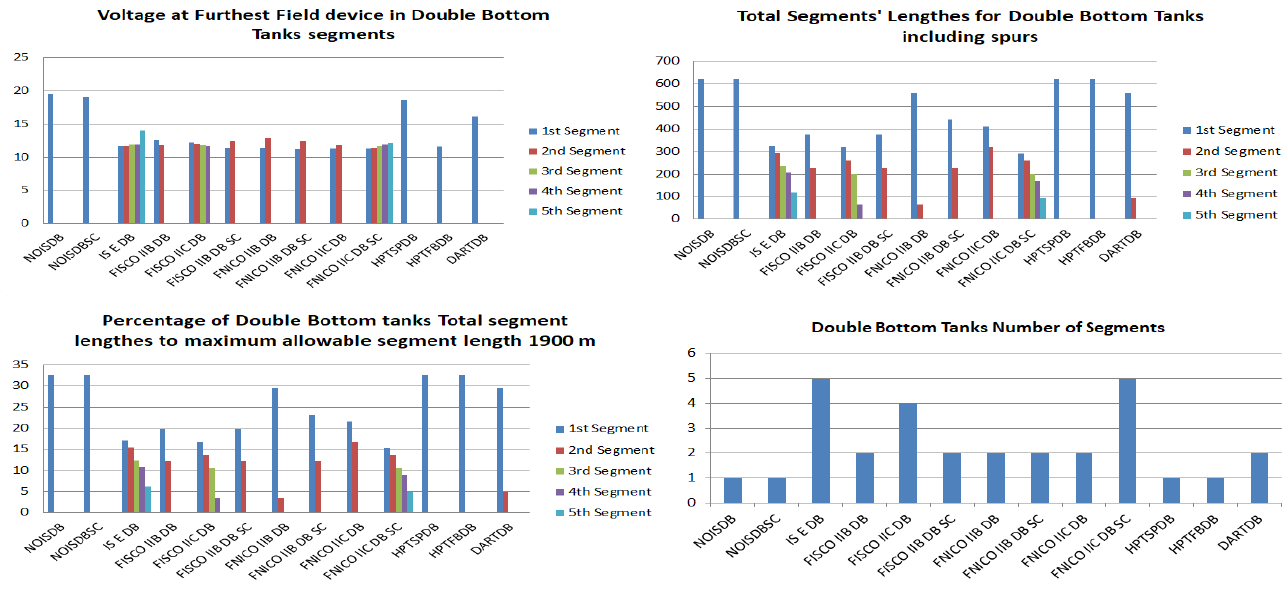
Figure 10. Illustration of voltage at farthest field devices, total segments’ lengths and percentage of them to the maximum allowable length of 1900 m and total number of segments for double bottom tanks’ sub-models.